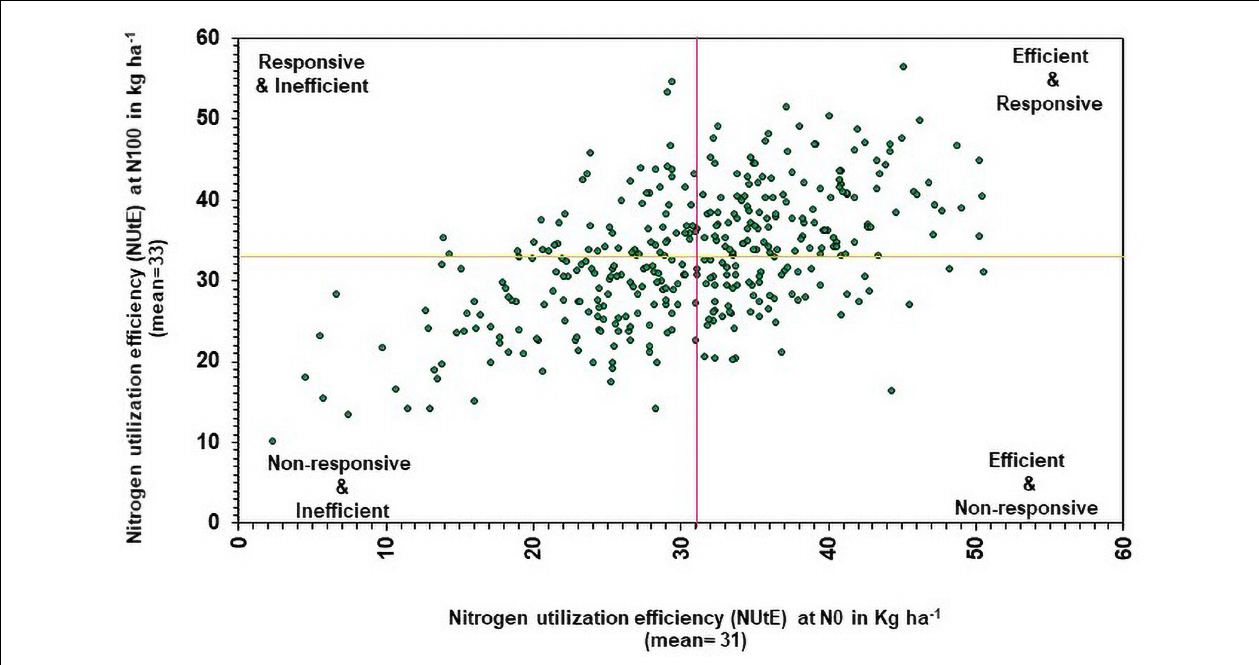
FIGURE 5 | Relationship between genotypes performance of nitrogen utilization efficiency (NUtE) under low (N 0 ) and recommended N (N 100 ) conditions. The yellow line represents the mean of NUtE at N 100 and the purple line represents the mean of NUtE at N 0 (pooled data from two summer seasons 2017 and 2018).